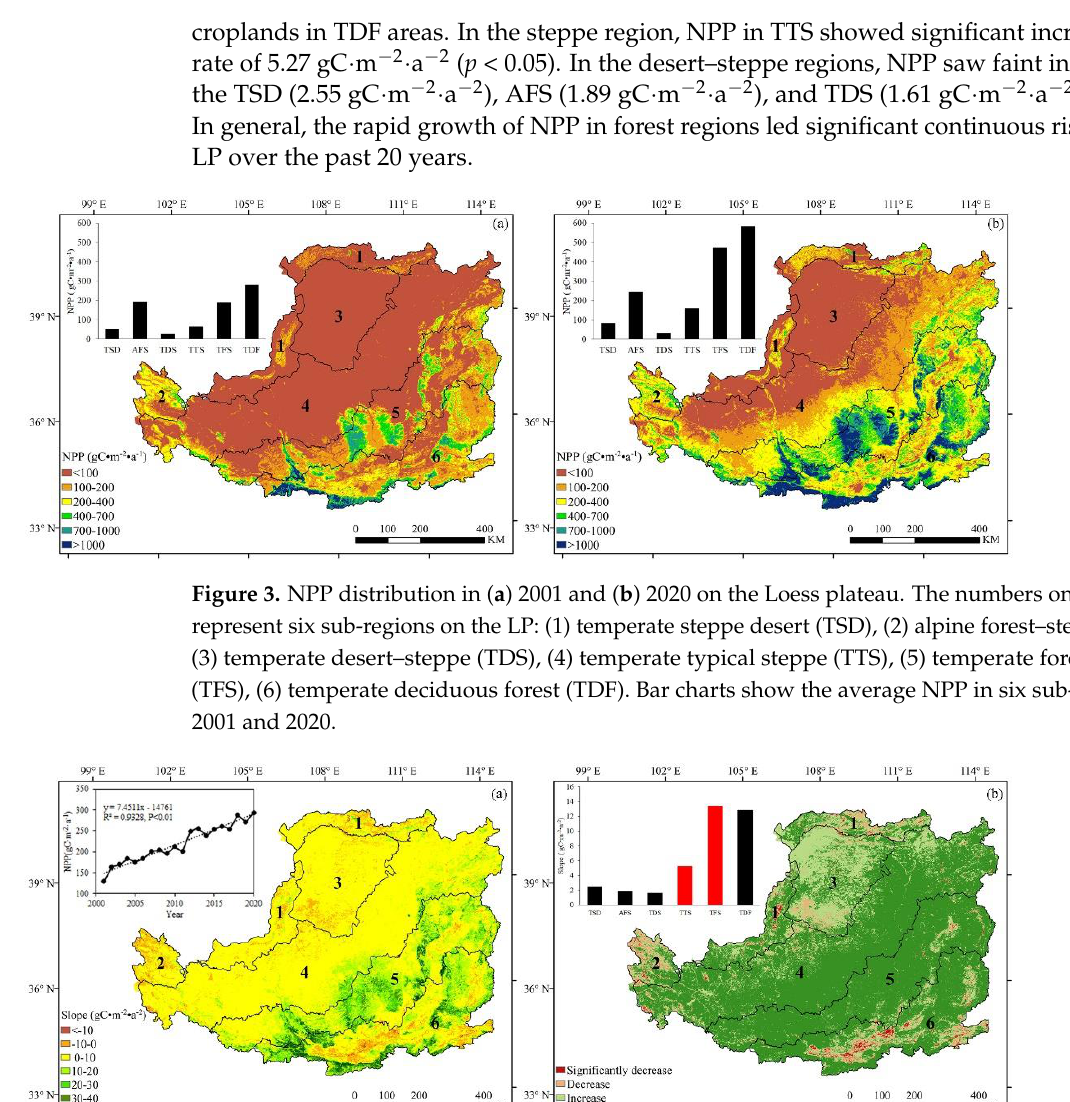
Figure 4. ( a ) Spatial patterns of variations of NPP on the LP during 2001 − 2020. The numbers on the pixels represent six sub-regions on the LP: (1) Temperate steppe desert (TSD), (2) alpine forest – steppe (AFS), (3) temperate desert – steppe (TDS), (4) temperate typical steppe (TTS), (5) temperate forest – steppe (TFS), (6) temperate deciduous forest (TDF). The line chart shows the trend in average NPP over the study area. ( b ) Significance of variations of NPP on the LP during 2001 − 2020. The red bar in the right panel indicates a significant increase ( p < 0.01) in average NPP over the TTS and the TFS regions.